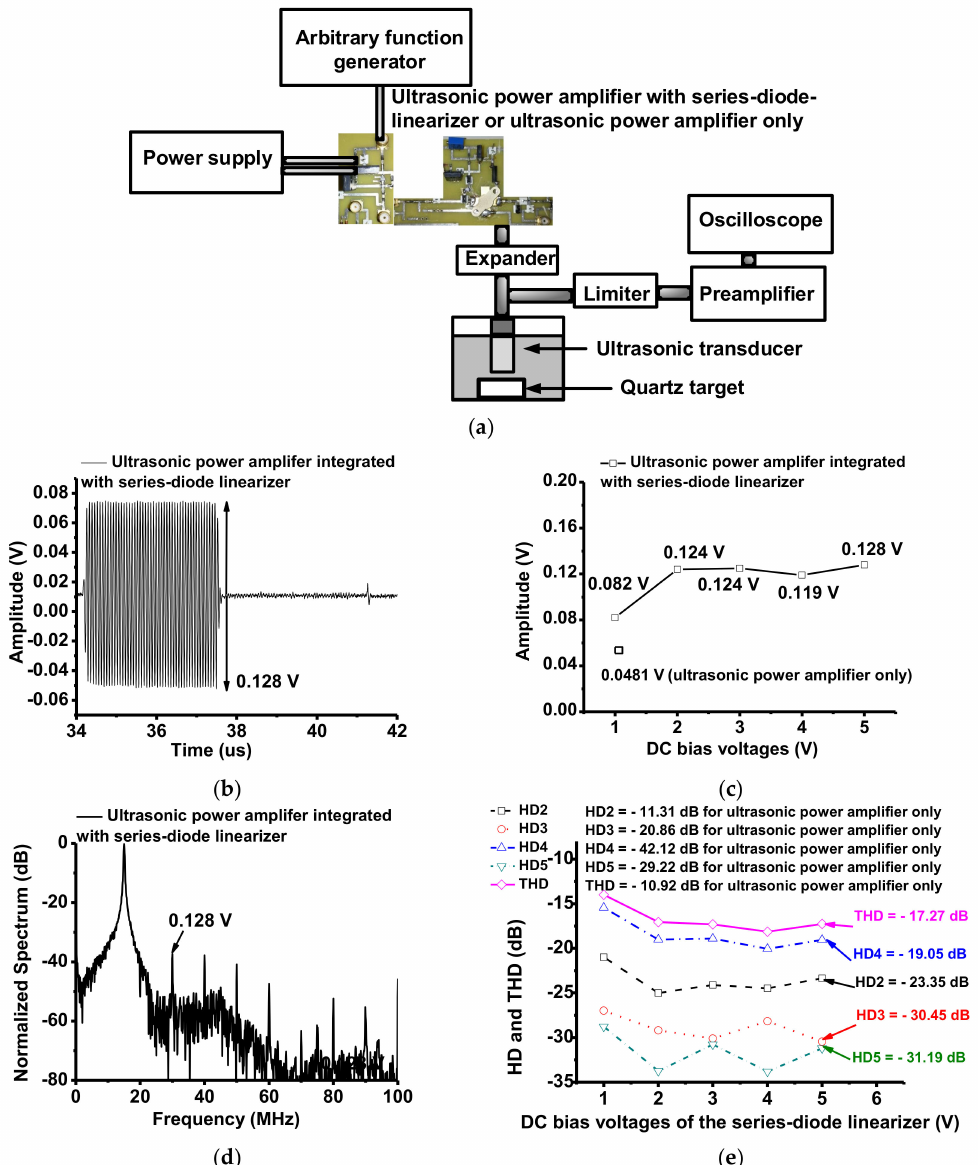
Figure 6. ( a ) Pulse-echo response setup; ( b ) Echo amplitude when using the ultrasonic power amplifier integrated with series-diode linearizer; ( c ) Echo amplitude comparison data when using the ultrasonic power amplifier with and without series-diode linearizer at 5 V DC bias voltage; ( d ) Spectrum data when using the ultrasonic power amplifier integrated with series-diode linearizer at 5 V DC bias voltage; ( e ) HD and THD comparison data of the echo signals of the ultrasonic transducers when using ultrasonic power amplifiers integrated with series-diode linearizer and the isolated ultrasonic power amplifier